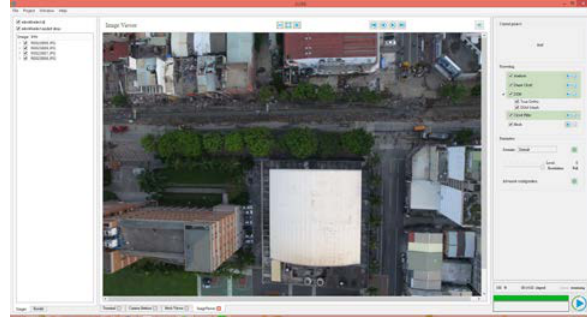
Figure 3. Operation in SURE